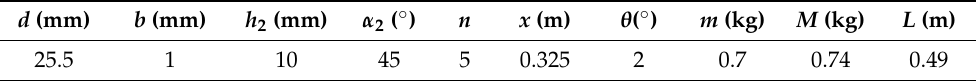
values and measured values for the duration under different working pressures, and the distance between the counterweight-installed positions. Table 1. Parameters for calculating duration using the theory.